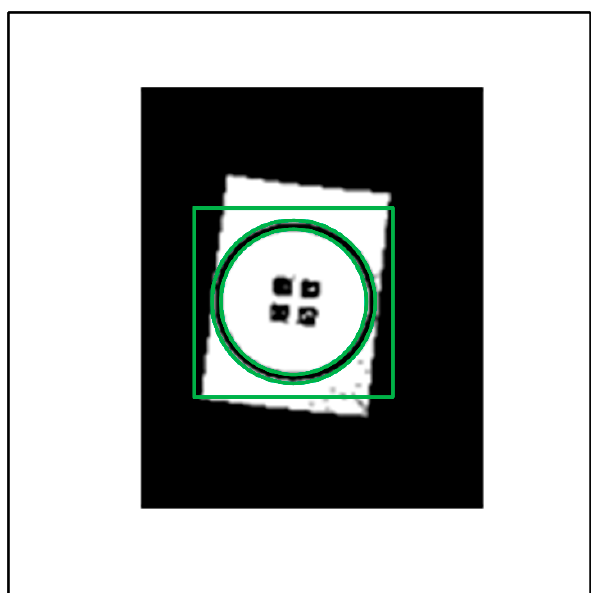
Figure 19. Bounding box area and detected circle. The ArUco markers are still not within range, but the circle helps obtaining a reference from long-range distance.